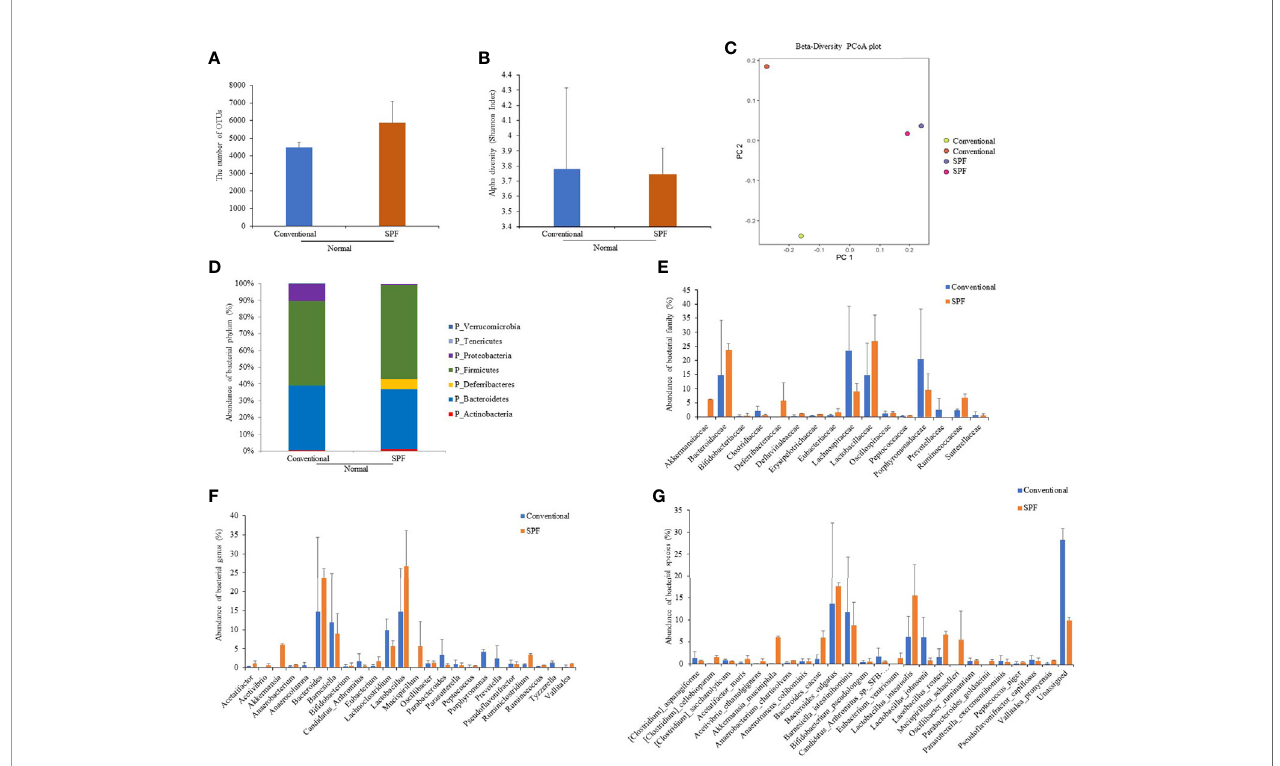
FIGURE 1 | Fecal samples were collected from normal mice maintained under conventional or SPF condition and 16S rRNA amplicons were sequenced for analysis. Microbiome analysis was performed using sequencing data of 16S rRNA V3 and V4 amplicons. The number of OTUs (A) and Alpha diversity (Shannon index) (B) , and Principal component analysis (PCA) plot (C) were calculated. Phylum (D) , family (E) , genus (F) , and species (G) showed signi fi cant differences in fecal 16S rRNA sequence analysis between groups. Two mice were used in each